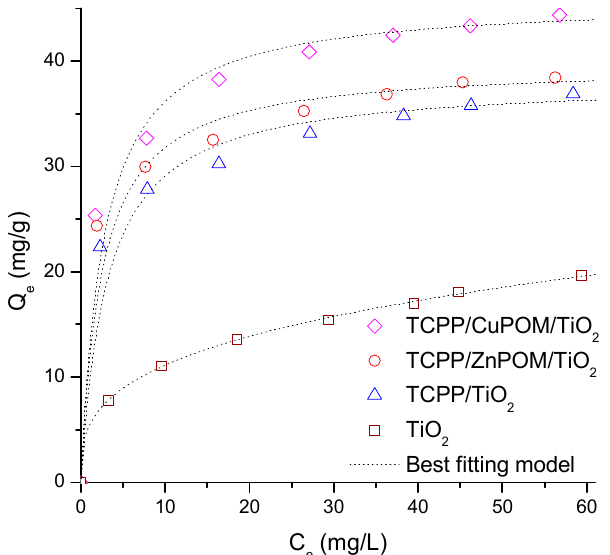
Figure 5. Experimental isotherm data for MB adsorption onto composite films. Inside the figure, the best fitting model is shown (Freundlich to TiO 2 and Langmuir isotherm to the rest of the materials). Table 2. Fitting results of Langmuir and Freundlich isotherm models. Model